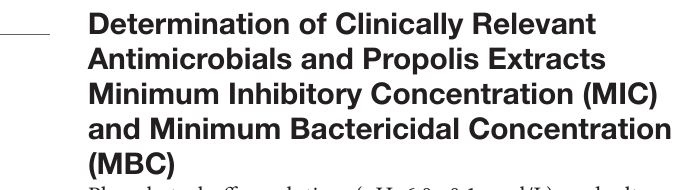
TABLE 2 | Antimicrobial sensitivity profile of C. pseudotuberculosi as determined by the disk diffusion method.